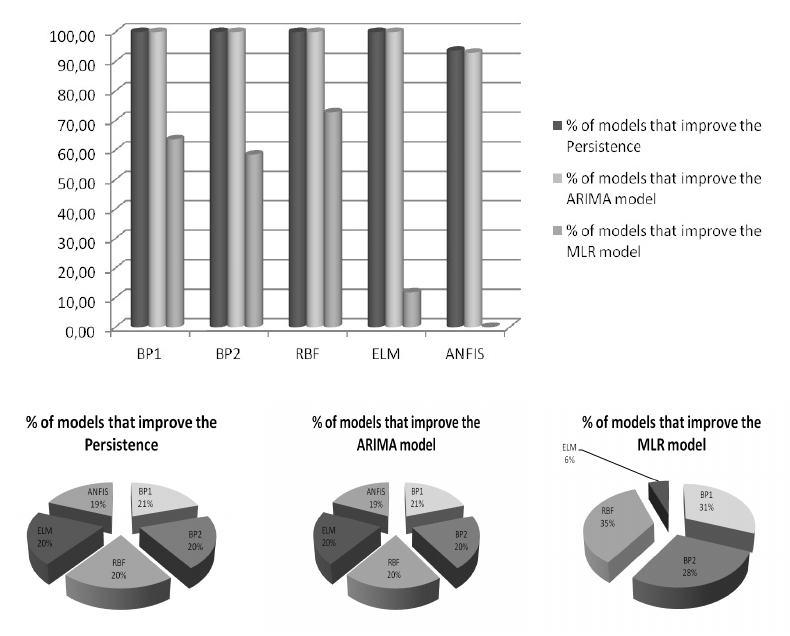
Figure 12. Overall improvements of the